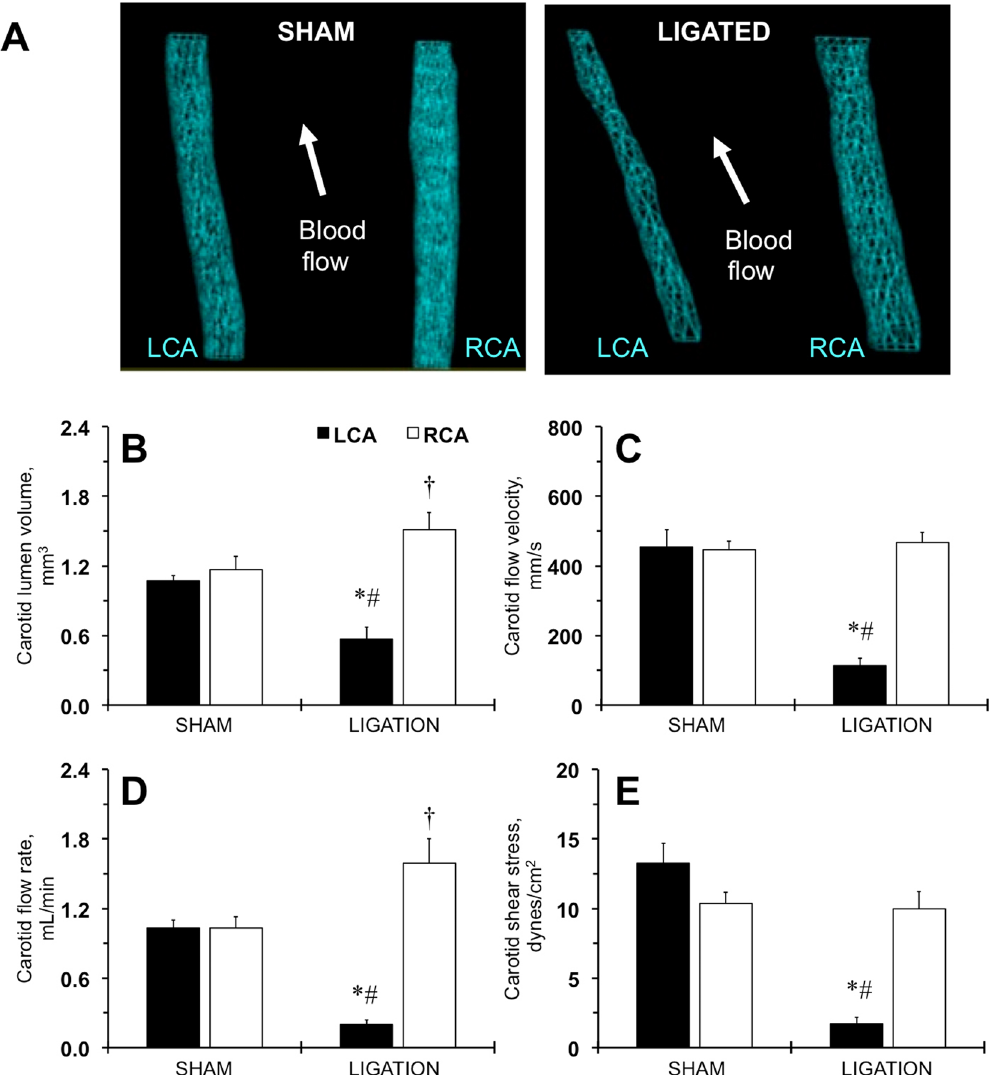
mice. LCA, left carotid artery. RCA, right carotid artery. Arrows show direction of the blood flow. ( B ) Carotid lumen volume, mm 3 . ( C ) Carotid blood flow velocity rate, mm/s. ( D ) Carotid blood flow volume rate, mL/min. ( E ) Carotid shear stress, dynes/cm 2 . Black bars are LCA. Open bars – RCA. SHAM and LIGATED mice are shown on X-axis. Values are mean ± SEM. * p < 0.05 vs. LCA, SHAM. † p < 0.05 vs. RCA, SHAM. # p < 0.05 vs. RCA, LIGATED. n = 5–6 per